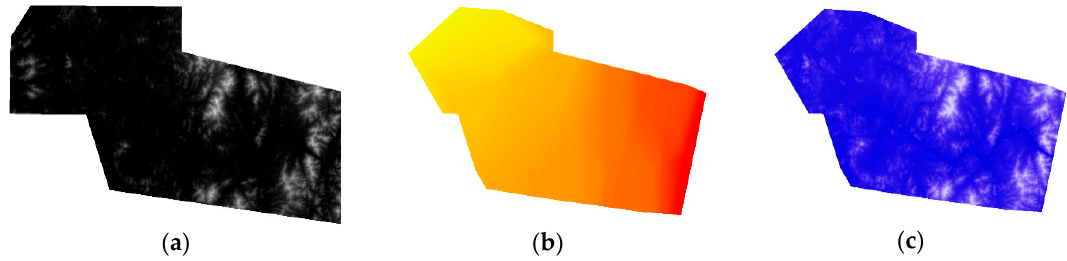
Figure 6. Digital elevation models for flood mapping. ( a ) Elevation DEM; ( b ) max W.S.E. DEM; ( c ) flood depth DEM.